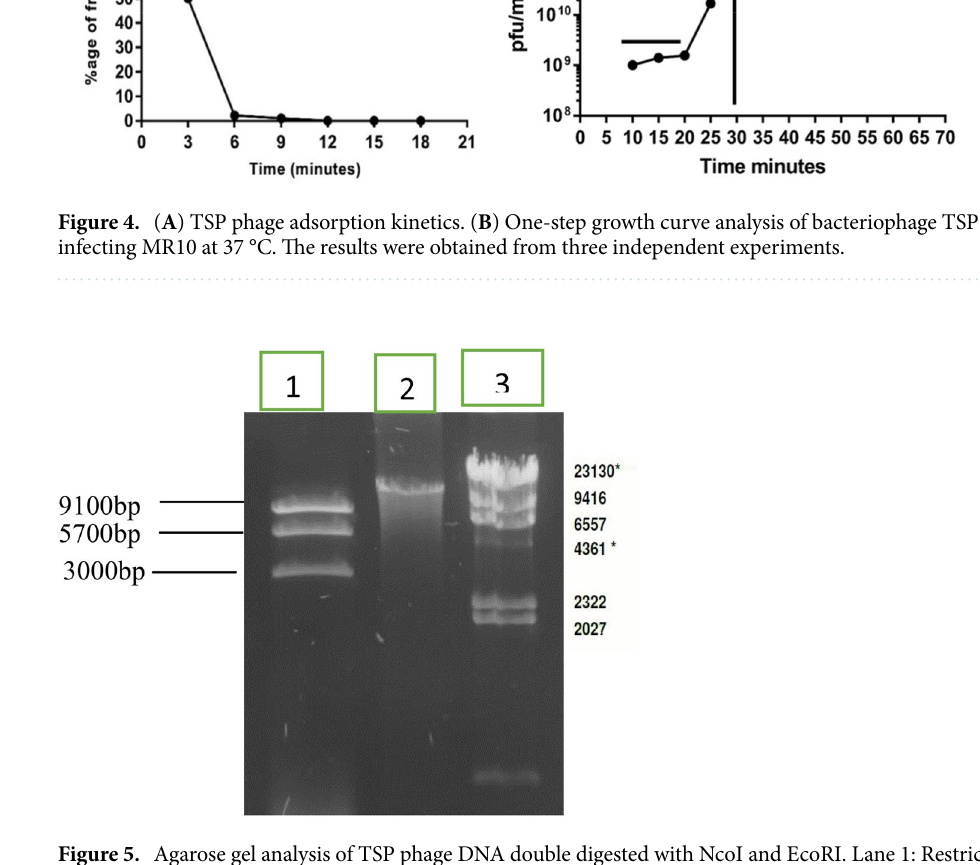
Figure 5. Agarose gel analysis of TSP phage DNA double digested with NcoI and EcoRI. Lane 1: Restricted TSP phage DNA, Lane 2: Unrestricted TSP phage DNA and Lane 3: Lambda phage DNA HindIII digested marker (Cat#302,005 Bioron). An uncroped agrose gel of the above figure isshown in Fig.